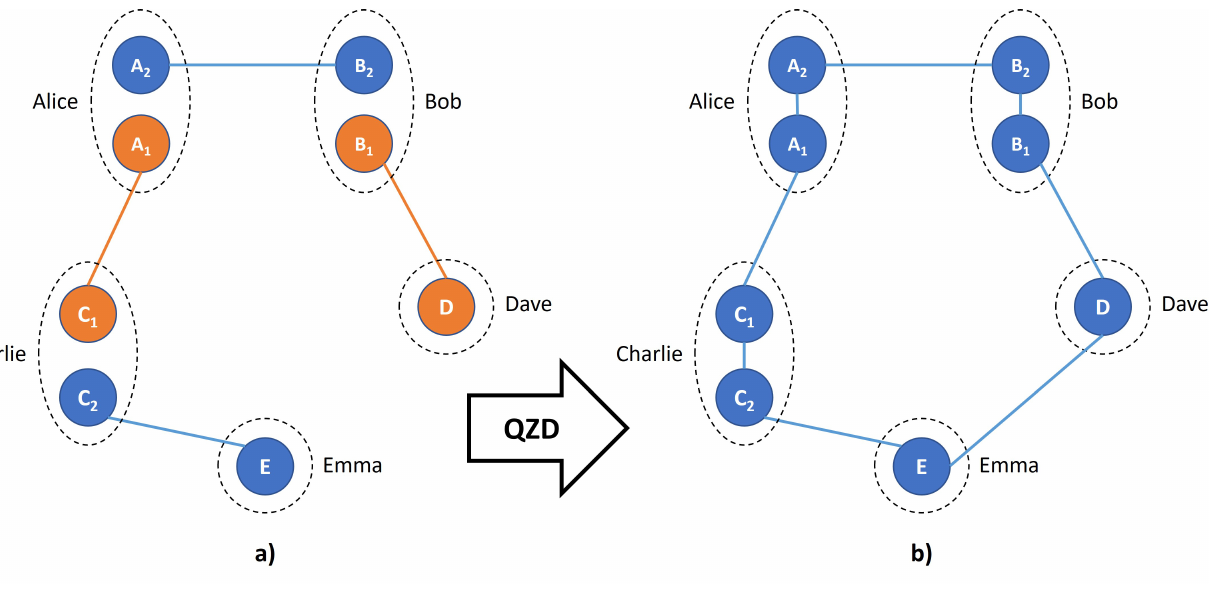
Figure 5. Superactivation of BE in ( a ) by entangling all the qubits via QZD results in a genuine eight-qubit FE state in ( b